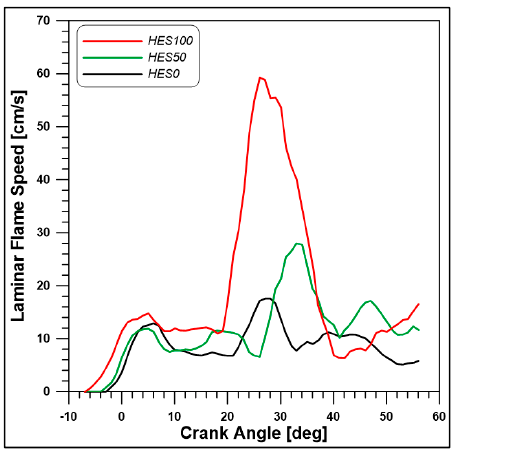
Figure 25. G function distributions for the different HES cases.